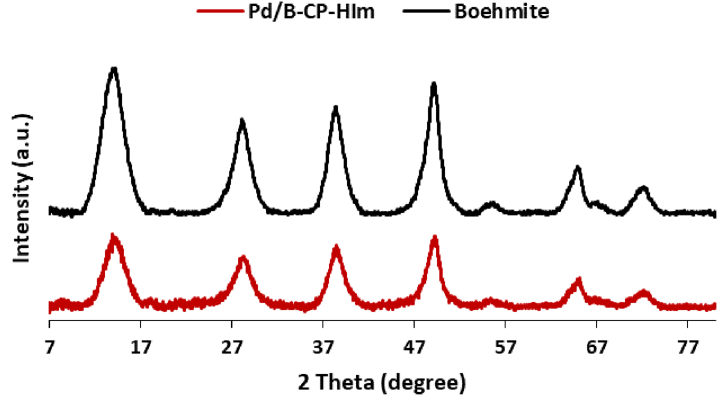
Figure 2. XRD patterns of boehmite and Pd/B-CP-HIm.